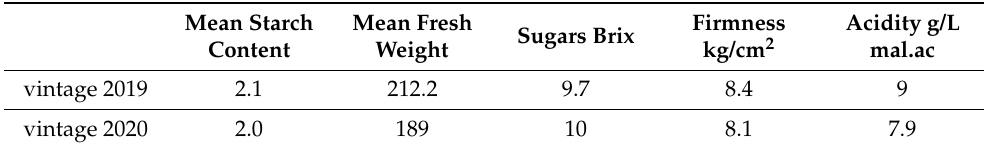
Table 2. Mean fresh weight and ripening parameters (starch content, sugar content (brix ◦ ), firmness and acidity) measured at harvest in the two experimental vintages 2019 and 2020 on the apples that have been used for the